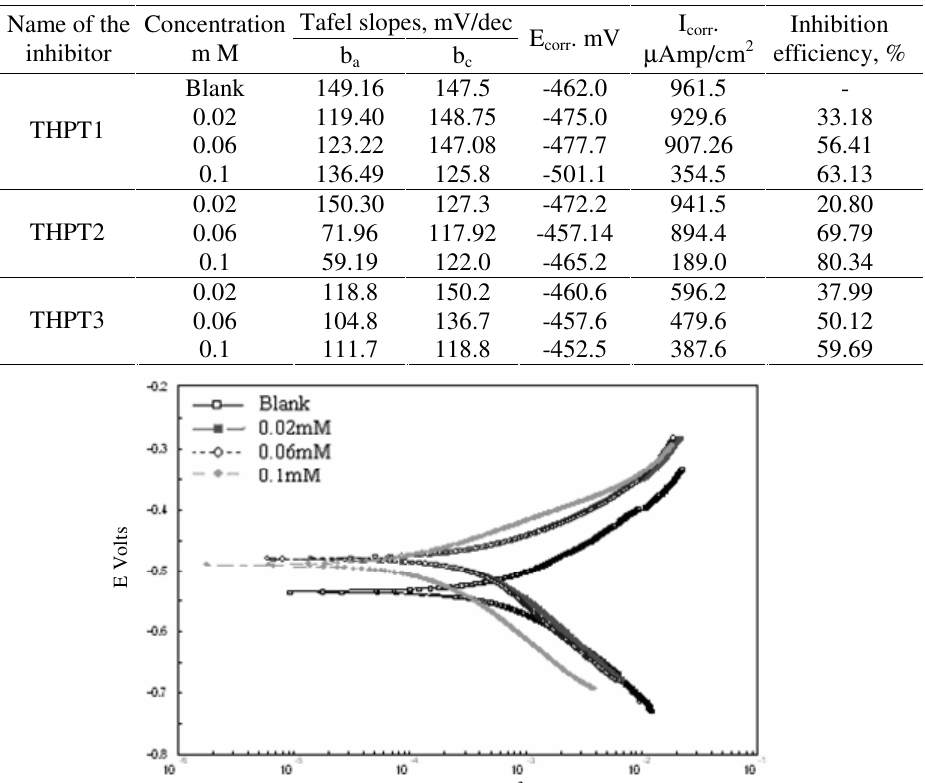
Table 5. Corrosion parameters for corrosion of mild steel with selected concentrations of the inhibitors in 1M H SO by potentiodynamic polarization method. 2 4